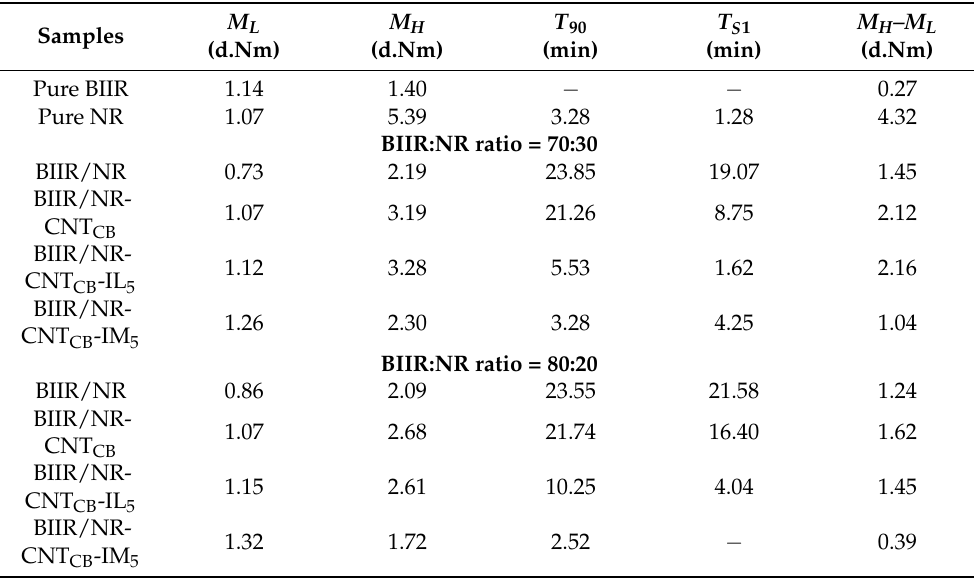
Figure 3. Cure characteristics curves of pure rubbers and their composites with and without IL and IM modifiers, BIIR:NR ratios of 70:30 ( A ) and 80:20 ( B ). Table 2. Cure characteristics of the pure rubbers and their